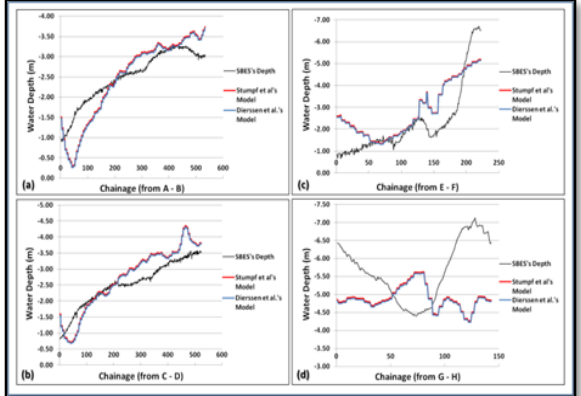
Figure 15. Cross-shore profiles of SBES and modelled depths spaced at the designated chainage. Validation plot (a) chainage A-B; (b) chainage C-D; chainage E-F; and (d) chainage